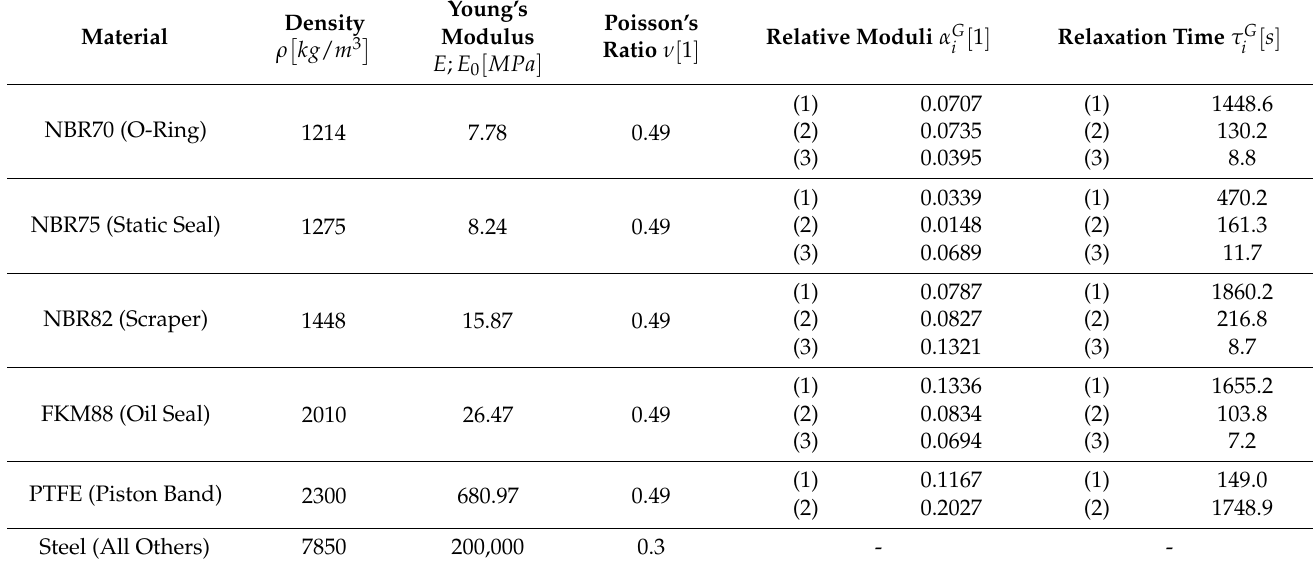
Table 1. Material model data for the FEM simulation, containing density, stiffness, lateral stiffness and the Prony model parameters.